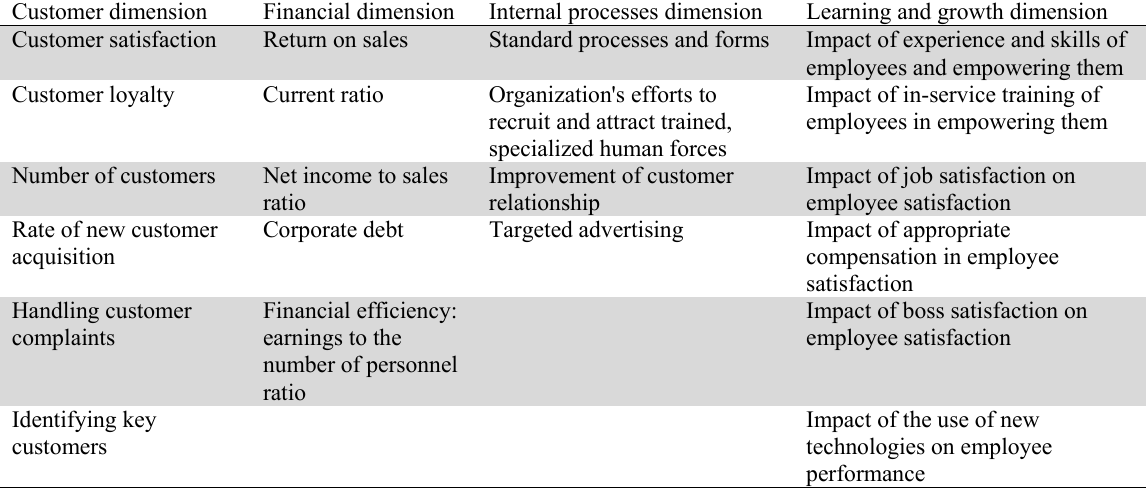
Final criteria extracted by